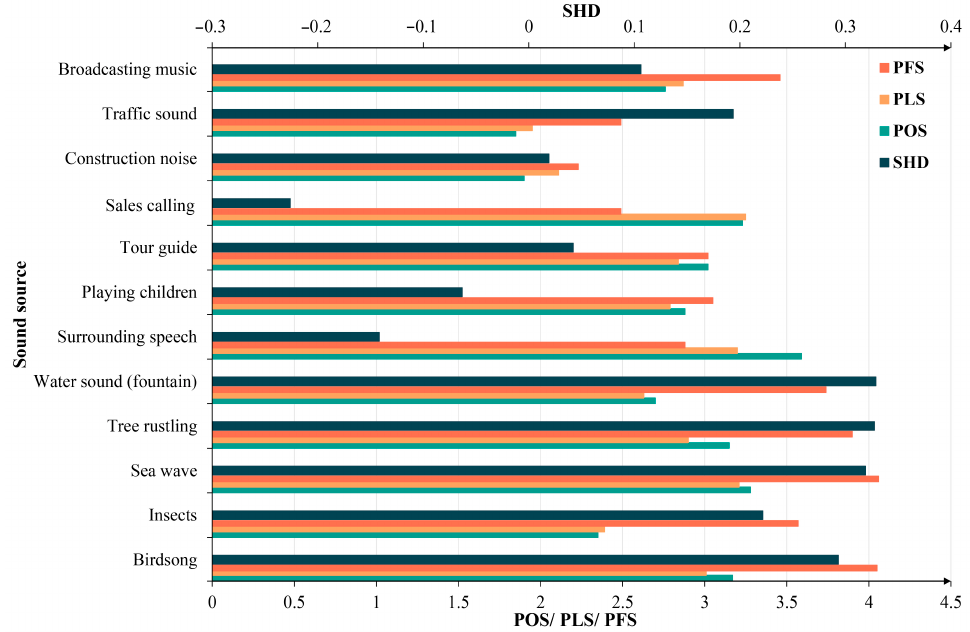
Figure 2. Mean values of sound source perception indicators, perceived occurrences (POS), perceived loudness (PLS), preference (PFS), harmonious degree of sound source (SHD).